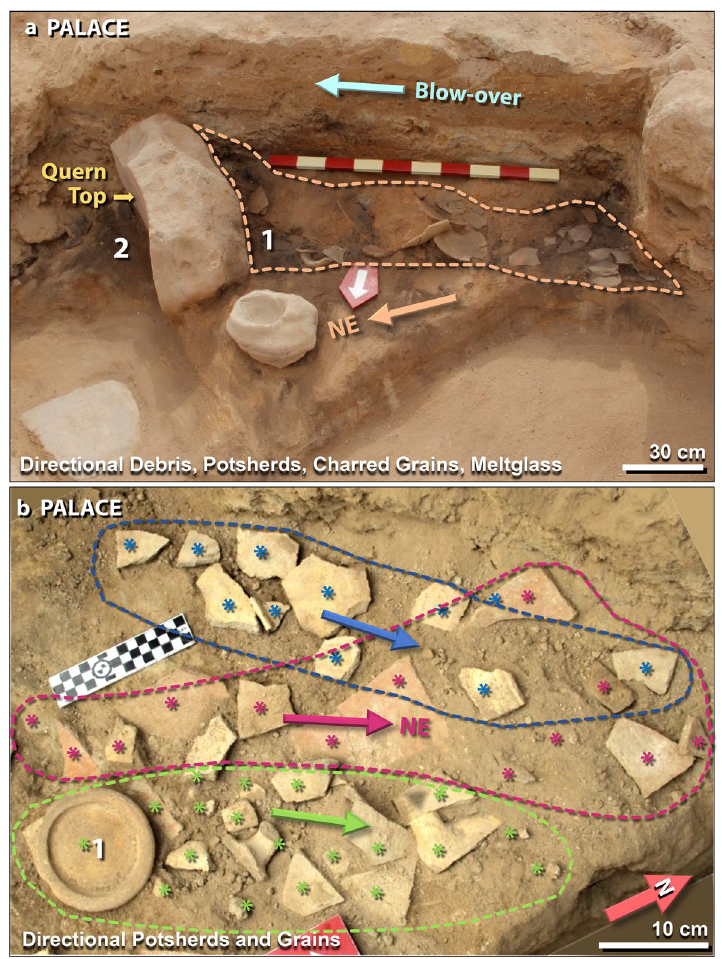
Figure 15. The directionality of mudbricks, potsherds, and grains. ( a ) 400-kg quern, at left, used for grinding grain, is tipped over with top towards NE. Image view spans ~ 2.5 m. Area #1 shows broken pottery and meltglass piled against quern from SW to NE (arrow). Area #2 contains charcoal, charred grains, ash, and mudbrick fragments, but no potsherds, suggesting that the quern shielded the floor to the NE. The area at the top labeled ‘blow-over’ is evidence that strong winds sealed the deposit with windblown laminated material that includes pulverized mudbrick, charcoal, ash, and fragments of white plaster. The draping of the blow- over indicates debris traveled from SW to NE. The scale stick is in 10-cm intervals. ( b ) Directional potsherds. Blue, red, and green asterisks (*) represent color-coded potsherds from three different pots. Arrows mark the motion of potsherds from SW to NE, spanning ~ 1 m. Area #1 represents the inverted bottom of the pot with its smaller fragments strewn to the left. Some pots contained charred grains also strewn in a SW-to-NE direction. Radiocarbon dates on charred grains confirm an age of ~ 1650 BCE (3600 cal